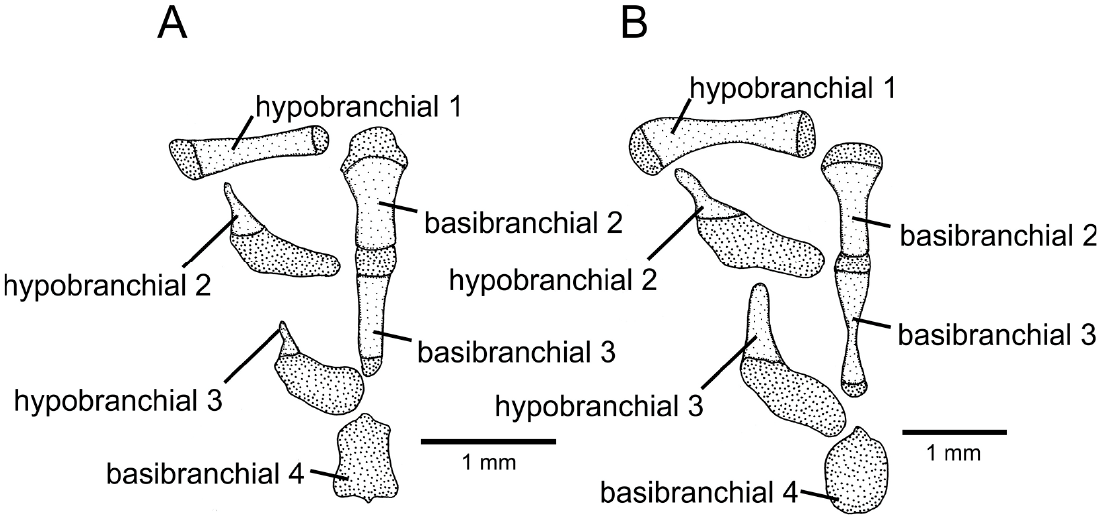
Figure 10. Ventral branchial arches, with left-central portion and in dorsal view: ( A ) Trichomycterus pirabitira ; ( B ) Trichomycterus ( Cryptocambeva ) saturatus Costa, Katz & Azevedo-Santos sp. nov. Larger stippling represents cartilage.